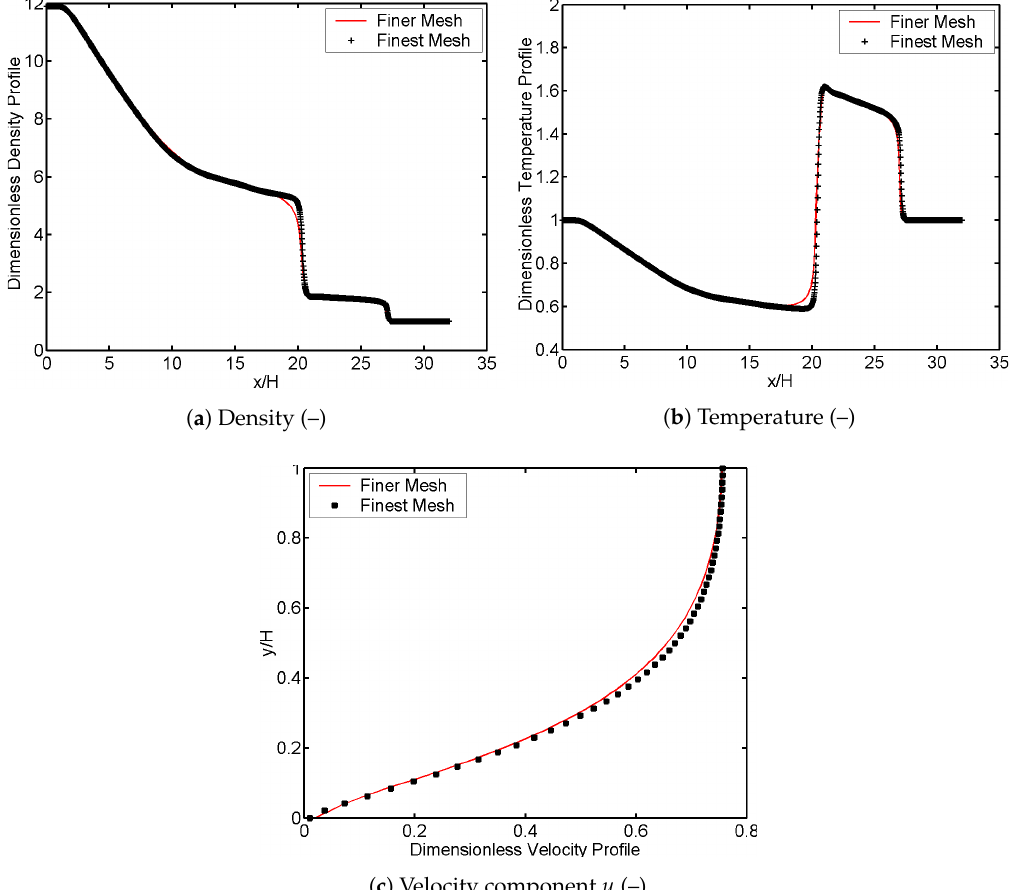
Figure 4. Dimensionless density ( a ); temperature profiles ( b ) in the centerline of the microchannel; and stream wise velocity u ( c ) in the cross section x = 25 H on the finer and the finest grid levels at the final time T f = 80 µ s with Kn =